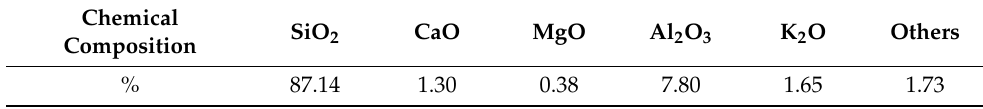
Table 2. Chemical composition of the quartz